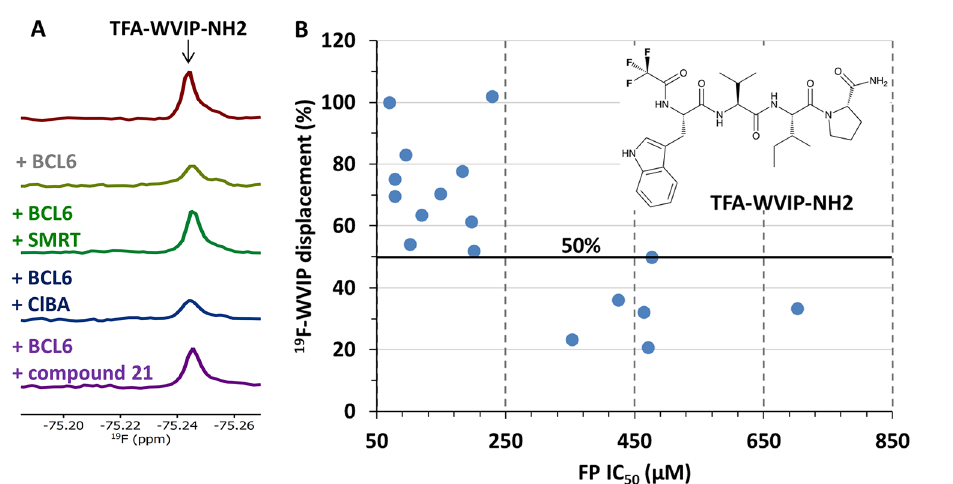
Figure 2. SPR results for the two hits showing the highest affinity for the BCL6 BTB dimer. ( A ) Sensorgrams of compound 17 at different concentrations. ( B ) Sensorgrams of compound 21 at different concentrations. ( C ) Corresponding binding curves and calculated K Ds for compounds 17 and 21 .